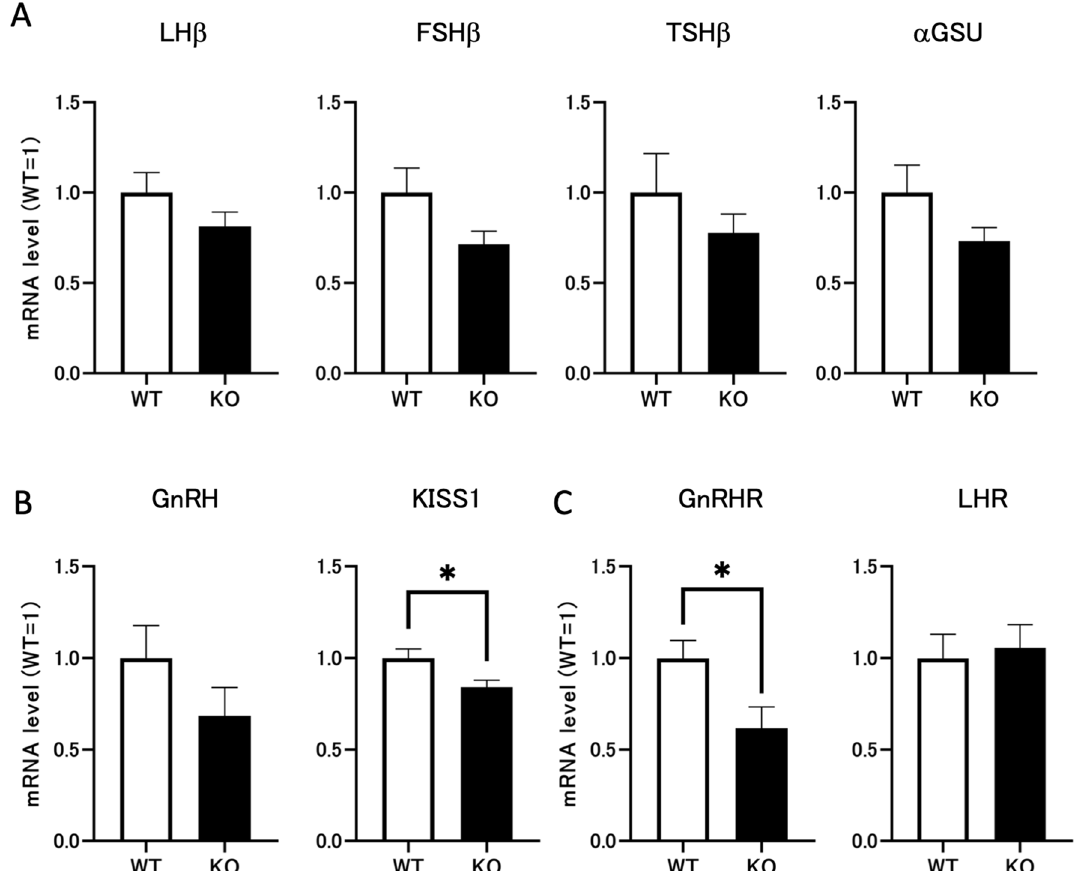
Figure 4. Effects of Dapl1 ablation on the production of gonadotropins in the hypothalamic-pituitary system. ( A ) Effect of Dapl1 ablation on the pituitary expression of mRNA coding for pituitary LHβ, FSHβ, TSHβ and αGSU in male mice at PND49. Each bar represents the mean ± S.E.M. of 11–12 mice. ( B ) Effect of Dapl1 ablation on the hypothalamus gene-expression of mRNA coding for GnRH and KISS1 in male mice at PND49. Each bar represents the mean ± S.E.M. of 4–5 mice. ( C ) Effect of Dapl1 ablation on the pituitary gene-expression of mRNA coding for GnRHR and the testicular steroidogenesis gene-expression of mRNA coding for LHR in male mice at PND49. Each bar represents the mean ± S.E.M. of 9–12 mice. Significantly different from the wild-type control: *p < 0.05. DAPL1 death-associated protein-like 1, LHβ luteinizing hormone β subunit, FSHβ follicle-stimulating hormone β subunit, TSHβ thyroid-stimulating hormone β subunit, αGSU glycoprotein hormone α-subunit, GnRH gonadotropin-releasing hormone, KISS1 kisspeptin, GnRHR gonadotropin-releasing hormone receptor, LHR luteinizing hormone receptor, PND49 postnatal day